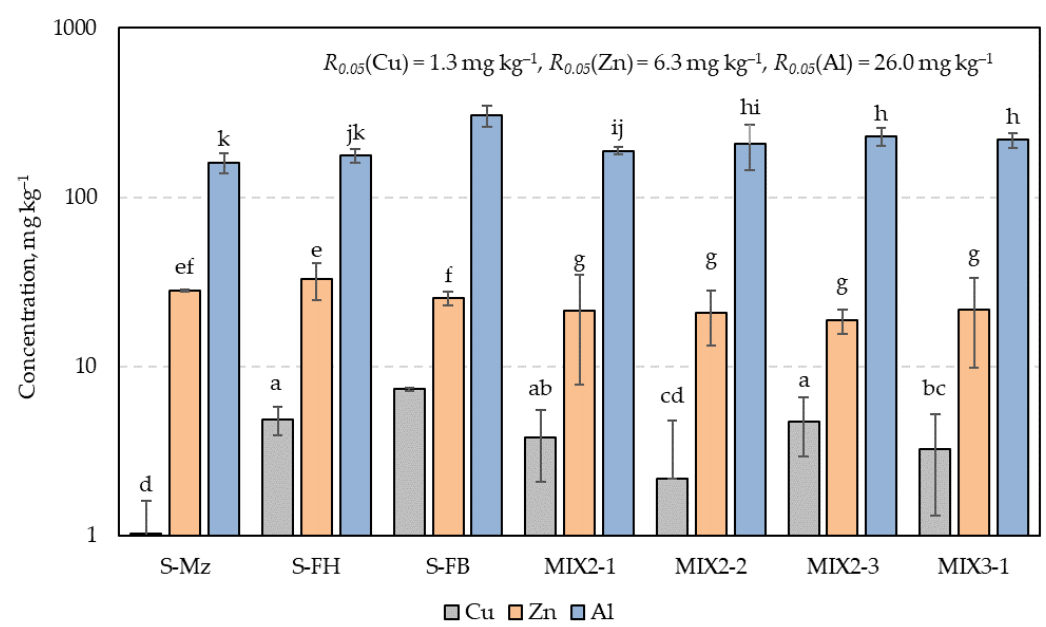
Figure 4. Results of Cu, Zn, and Al analysis. In the figure, any two samples with a common letter are not significantly different, as assessed using the least significant difference.